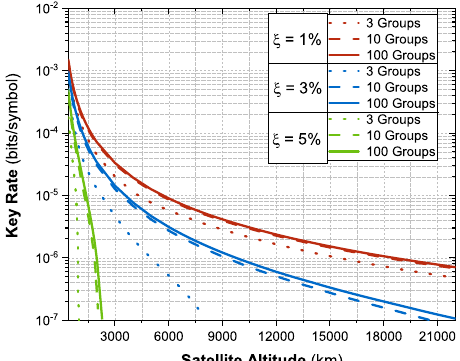
Fig. 7 Asymptotic key rate vs satellite altitude. Secret key rate for channel subdivision in 3, 10, and 100 groups and different values of the fi xed excess noise, ξ fi x : (in S.N.U), 1% (red), 3% (blue), and 5% (green). The key rate in bits/s can be calculated by multiplying by the transmission symbol